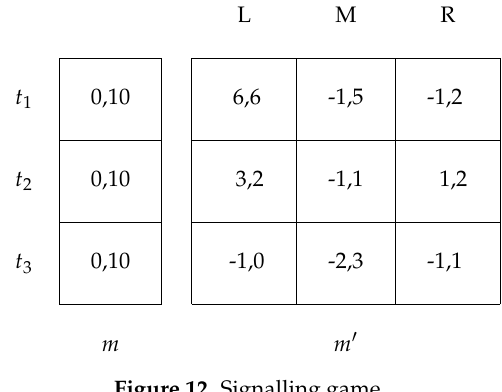
Figure 12. Signalling